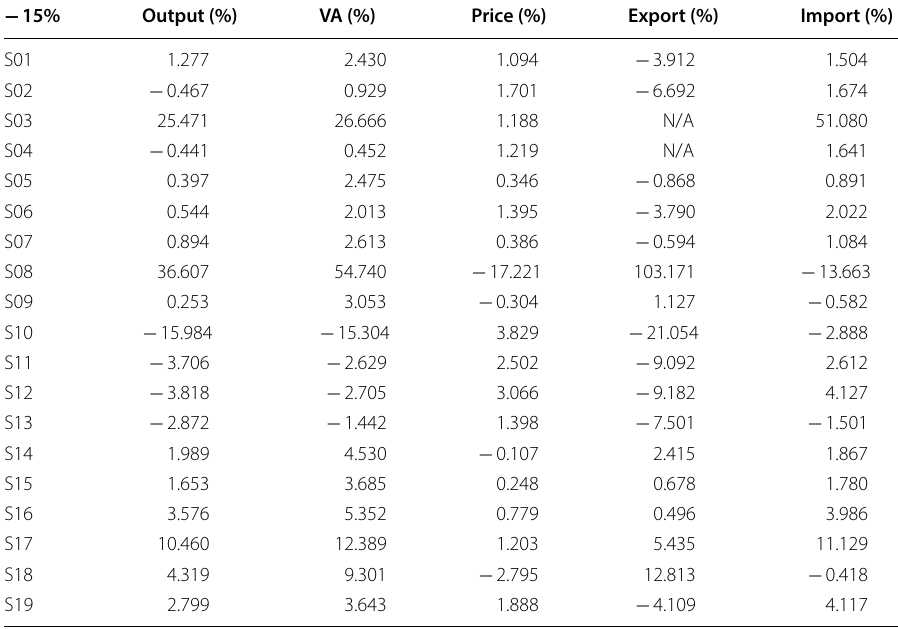
Table 5 The effects of a 15% decrease in crude oil domestic